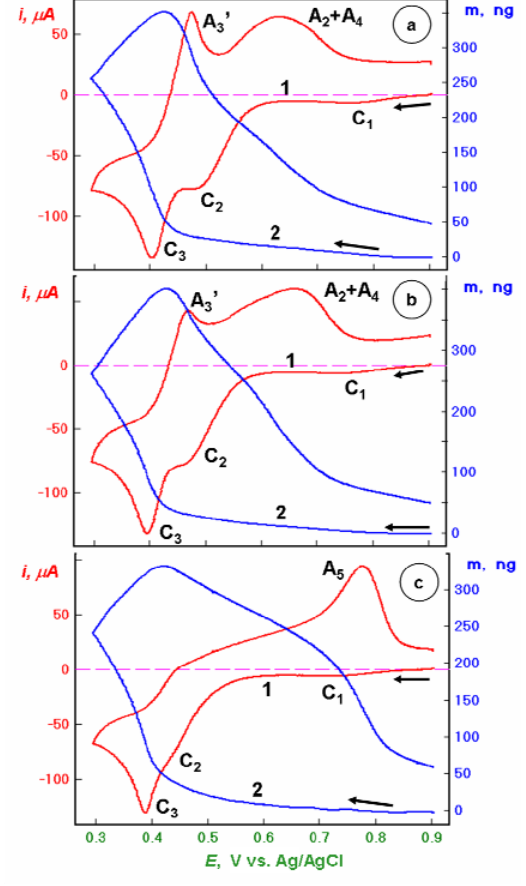
Figure 1. Linear potential scan voltammetric (1) and nanogravimetric (2) characteristics of piezosensors: (a) bare Au, (b) Au/CA, and (c) Au/CA-GSH, recorded in 0.1 M NaClO mM HClO + 1.5 mM Hg(ClO ) solution, in the potential range from E = +0.9 to +0.3 V 4 4 2 vs. Ag/AgCl, at a scan rate v = 50